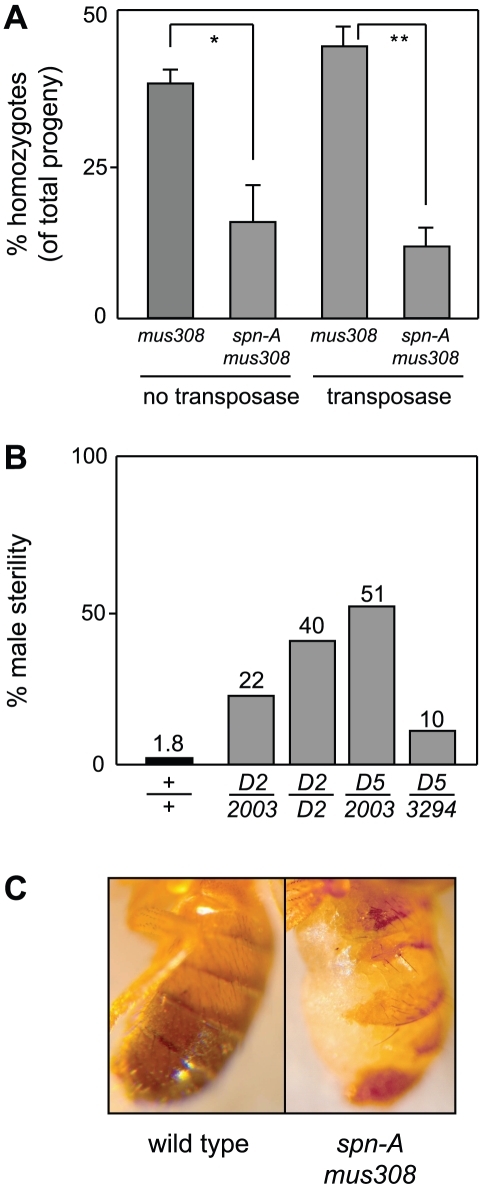
Flies lacking Rad51 and Pol θ have synergistic phenotypic defects.(A) spn-A mus308 mutants are sub-viable. Females and males with the P(wa} transposon and heterozygous for the spn-A057 or spn-A093 and mus308D2 or mus308D5 alleles were interbred and the percentage of viable compound heterozygous progeny was determined. The crosses were repeated in the presence of P transposase. Each bar represents three independent experiments with at least 300 progeny per experiment. Error bars represent SEM. * indicates p<0.05, ** indicates P<0.01 (unpaired T test). (B) Increased male sterility in spn-A mus308 double mutant males. Each bar represents the percentage of spn-A or spn-A mus308 males that produced no progeny. Number of independent males assayed: spn-A = 57; spn-A057mus308D2/spn-A057mus3082003 = 305; spn-A057mus308D2/spn-A057mus308D2 = 50; spn-A093mus308D5/spn-A057mus3082003 = 102; spn-A093mus308D5/spn-A093mus3083294 = 100. (C) Mutation of both spn-A and mus308 results in external morphological defects such as abdominal cuticle mispatterning (note the severe disruption of normal segmental banding patterns). Pictured are representative wild type and spn-A057mus308D2/spn-A057mus3082003 males in which P element excision is occurring.